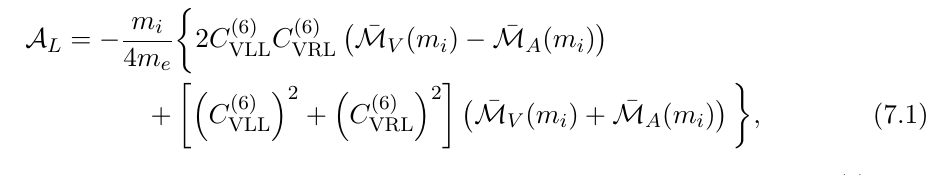
= (cid:3) ) 2 n and the loop expansion breaks down. Instead, i (cid:31)